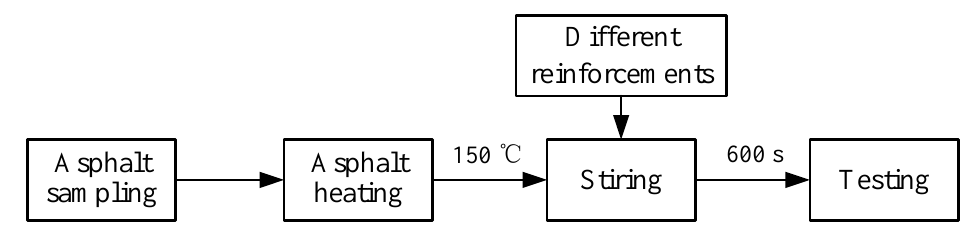
Figure 2. Modified asphalt preparation process.